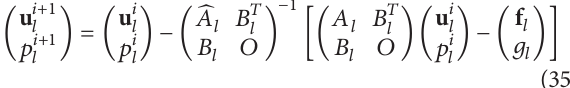
Algorithm 4. (1) For 𝑖 = 1 : smoothing